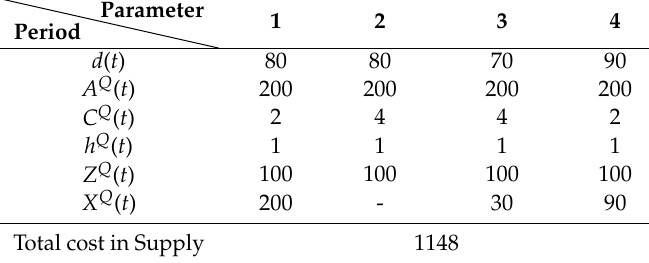
Table 2. Supply Model result.